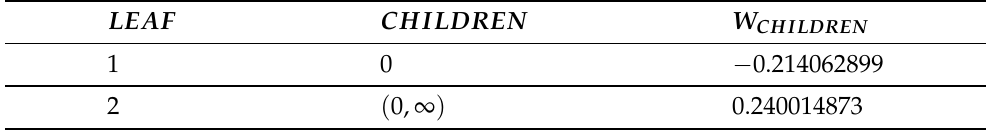
Table 3. Values obtained for W CHILDREN from the tree depicted in Figure 4 (right).